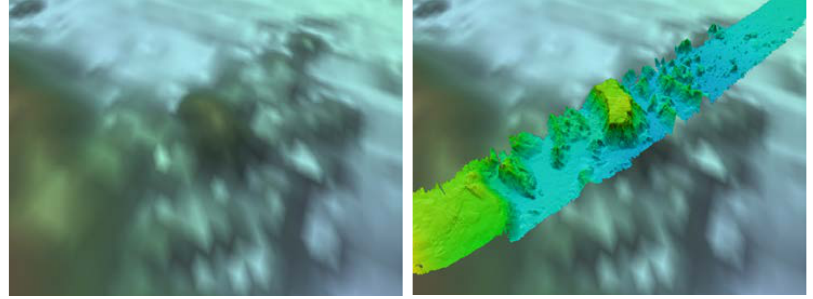
Figure 4. Satellite-derived bathymetry (including single-beam sonar data) from SRTM 30_Plus off Hawaii ( left ). Single swath of 12 kHz multibeam sonar over the same area—swath width = 20 km for scale ( right ).